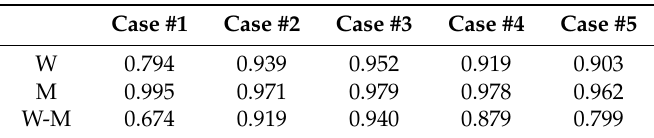
Table 1. Correlation coefficients examined by Spearman Rank Order between reflectance and excluded duration (W-M) for case #1 to case